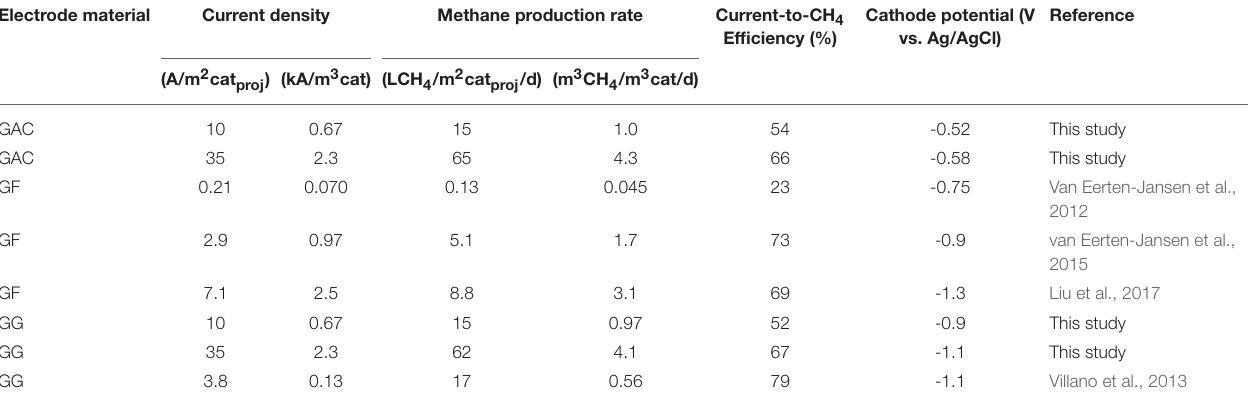
TABLE 1 | Comparison of methane production rates for similar 3D carbon-based electrodes in methane-producing BESs when water was used as electron donor. Electrode material